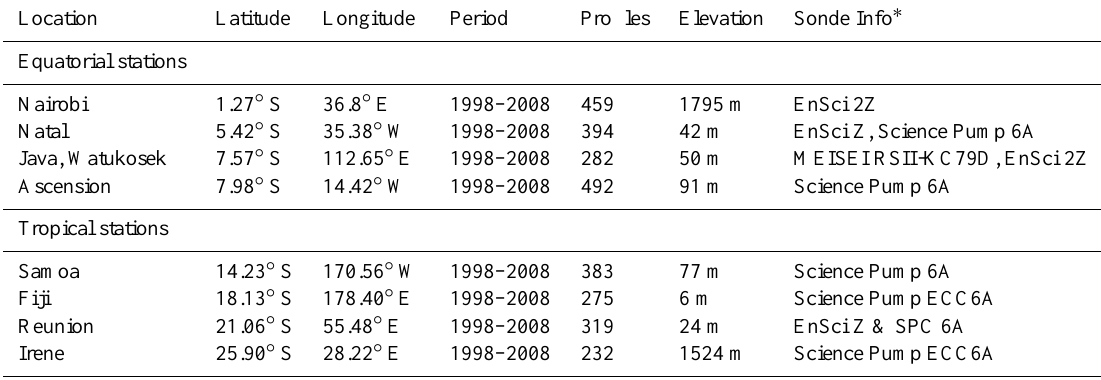
Table 1. Overview of SHADOZ stations used in this study. Location Latitude Longitude Period Profiles Elevation Sonde Info ∗